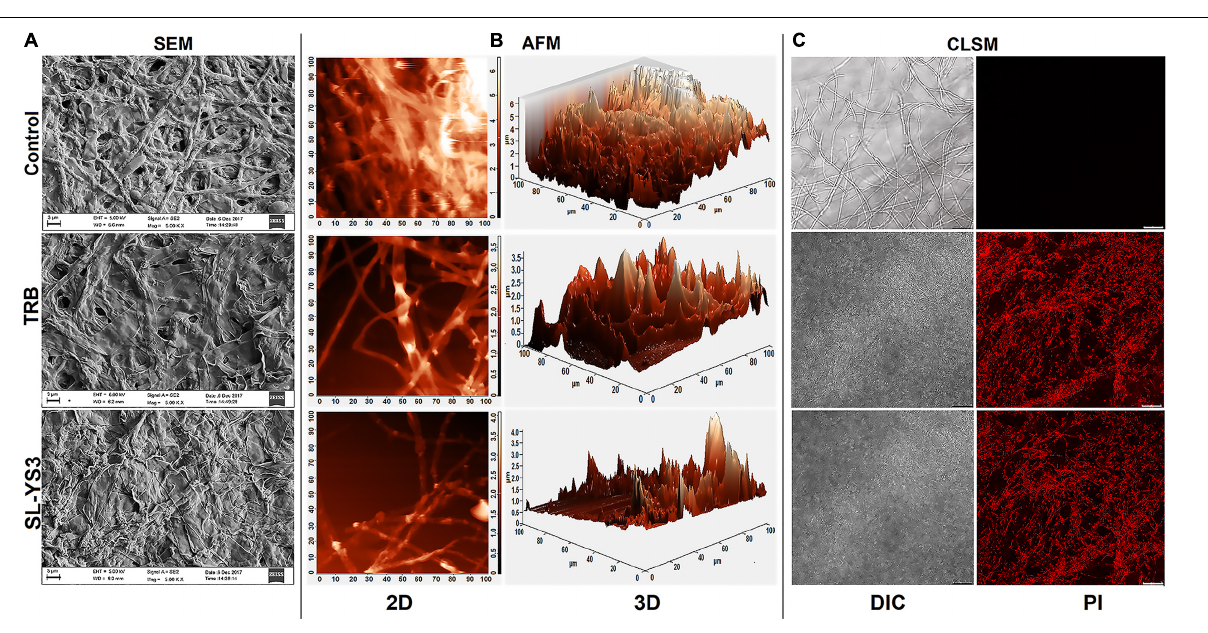
reduction of the biofilms was observed ( F 4 , 40 =